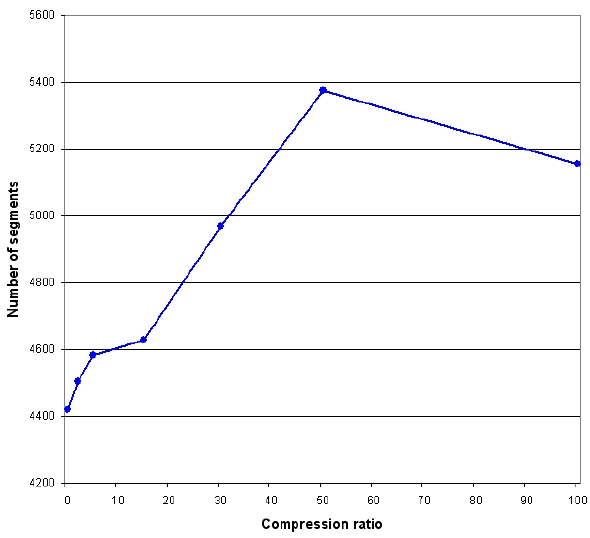
Figure 4. Number of